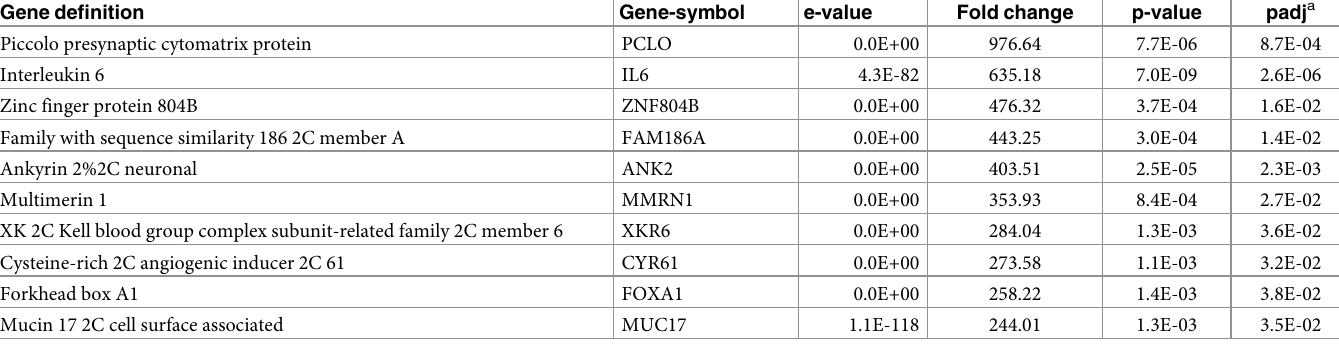
(both up and downregulated) were grouped into pathways involved in cellular and disease pro- cesses using PathwayStudio ™ . This program identifies relationships between genes and disease based on knowledge harvested from millions of published articles in PubMed and compares the genes that are differentially expressed in an experiment to the knowledgebase using Table 3. Top 10 downregulated genes of Florida manatees exposed to red tide as compared to the experimental control